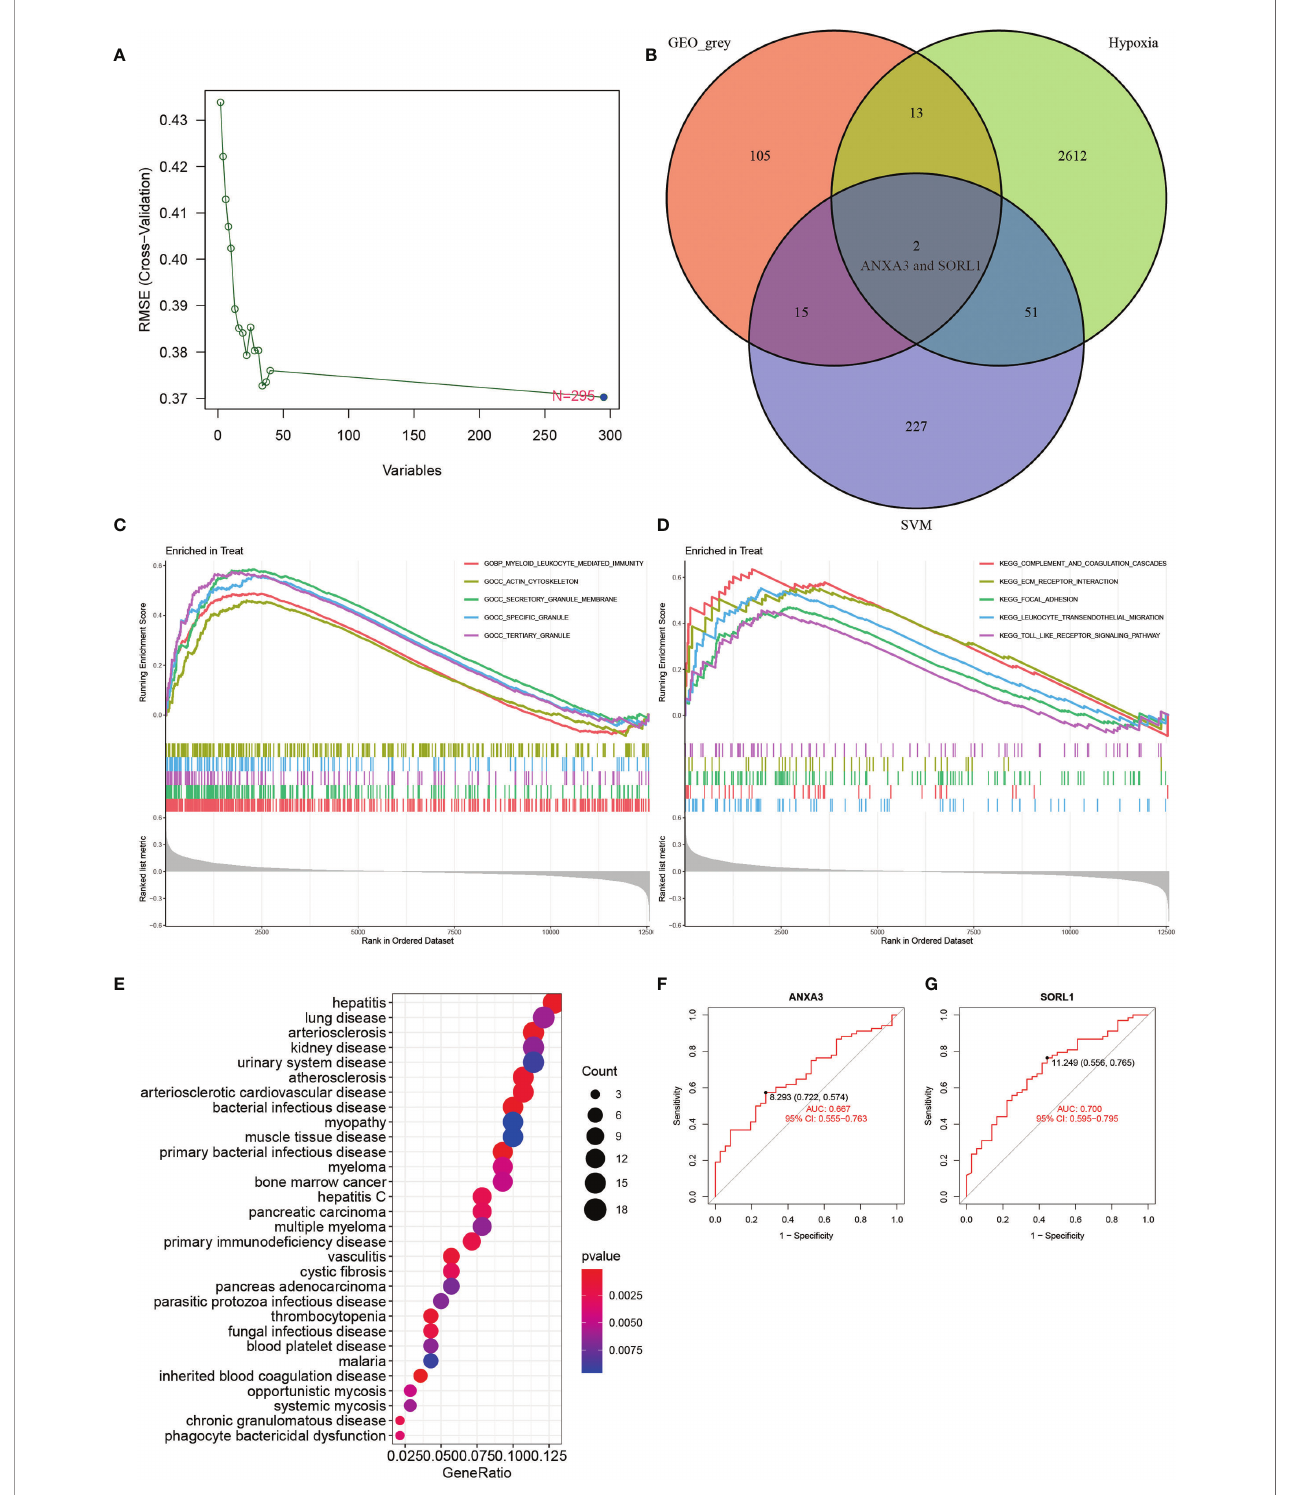
FIGURE 3 | SVM analysis, GSEA, DO analysis, veen plot and ROC curve. (A) shows the results of SVM analysis. (B) shows the results of intersection of GEO_grey module, hypoxia-related genes and SVM analysis. (C, D) show the results of GO and KEGG from GSEA enrichment analysis. (E) shows the results of DO enrichment analysis. (F, G) show the ROC diagnostic curves of 2 genes of the model. (F, G) show the ROC curves of 2 genes of the